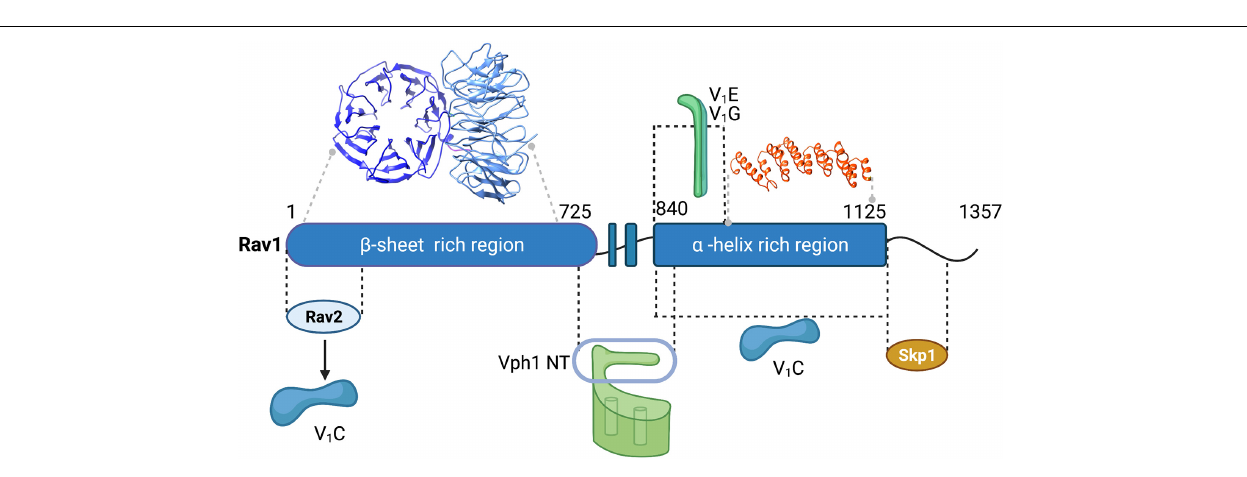
FIGURE 3 | Map of interactions between yeast RAVE subunits and the V-ATPase and structural modeling of Rav1. Regions of interaction between subunits of the RAVE complex and between RAVE and V-ATPase subunits (labeled in Figure 1 ) are shown (Smardon et al., 2015). Structural models for two regions of Rav1 are also shown. Amino acids 2-672 of Rav1 were modeled on the double propeller of Apaf-1 (apoptotic protease activating factor-1;PDB 5JUY) by the Phyre2 server (Kelley et al., 2015). There is 14% amino acid sequence identity in this region, which was modeled with 100% confidence. In the view shown, the first β -propeller is viewed from the top, while the second β -propeller is viewed from the side. Amino acids 937–1113 of Rav1 were modeled on the α -solenoid region of chain A of gemin-5 (PDB 6RNS). There is 18% amino acid sequence identity with this region of Rav1, and it was modeled to the single highest scoring template with a confidence estimate of 98.7%. Black lines indicate regions exhibiting protein-protein interactions and gray lines indicate regions corresponding to the homology